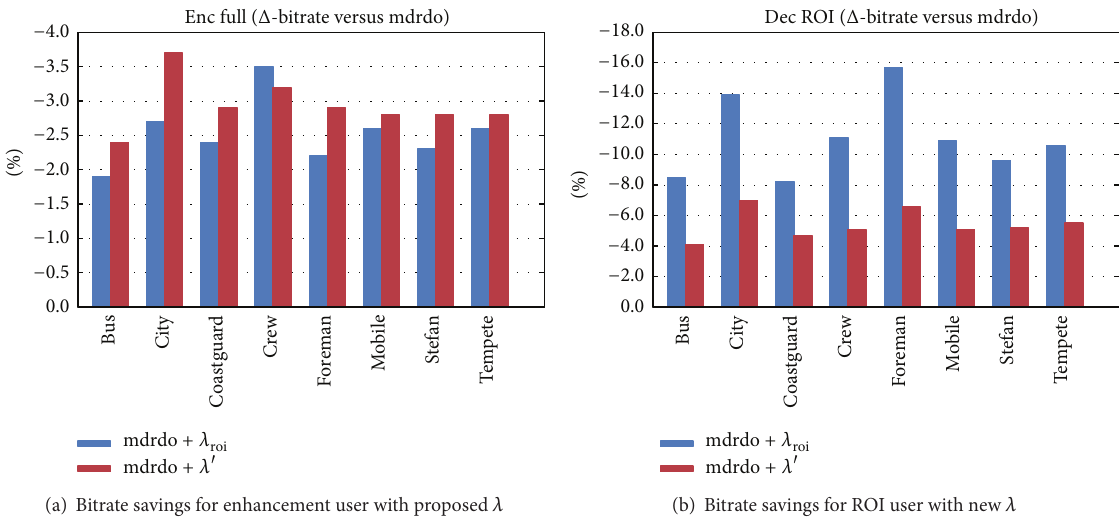
(b) Bitrate savings for ROI user with new 𝜆 Figure 8: RD performance for spatial SVC with new 𝜆